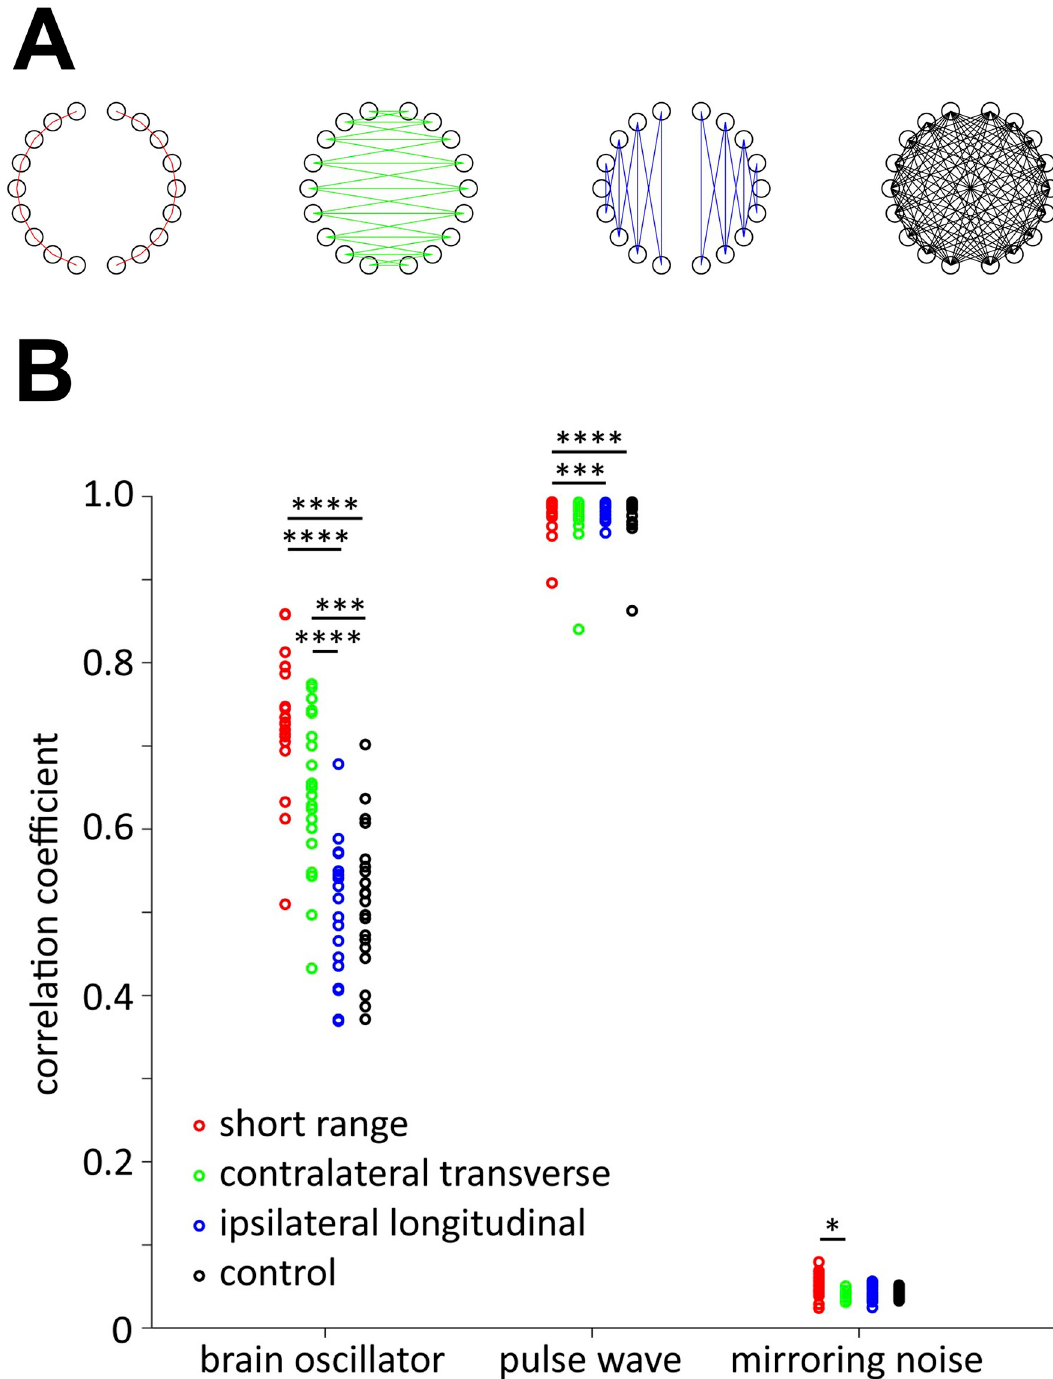
Fig 18. Mean correlation coefficients of each infant for the four types of functional connectivities. (A) Short range (red), contralateral transverse (green), ipsilateral longitudinal (blue), and control (black) connectivities. (B) Red, green, blue, and black lines indicate individual data for short-range, contralateral transverse, ipsilateral longitudinal, and control connectivity, respectively. ���� p < 0.001, ��� p < 0.005, �� p < 0.01, and � p < 0.05 after Bonferroni correction for multiple comparisons.